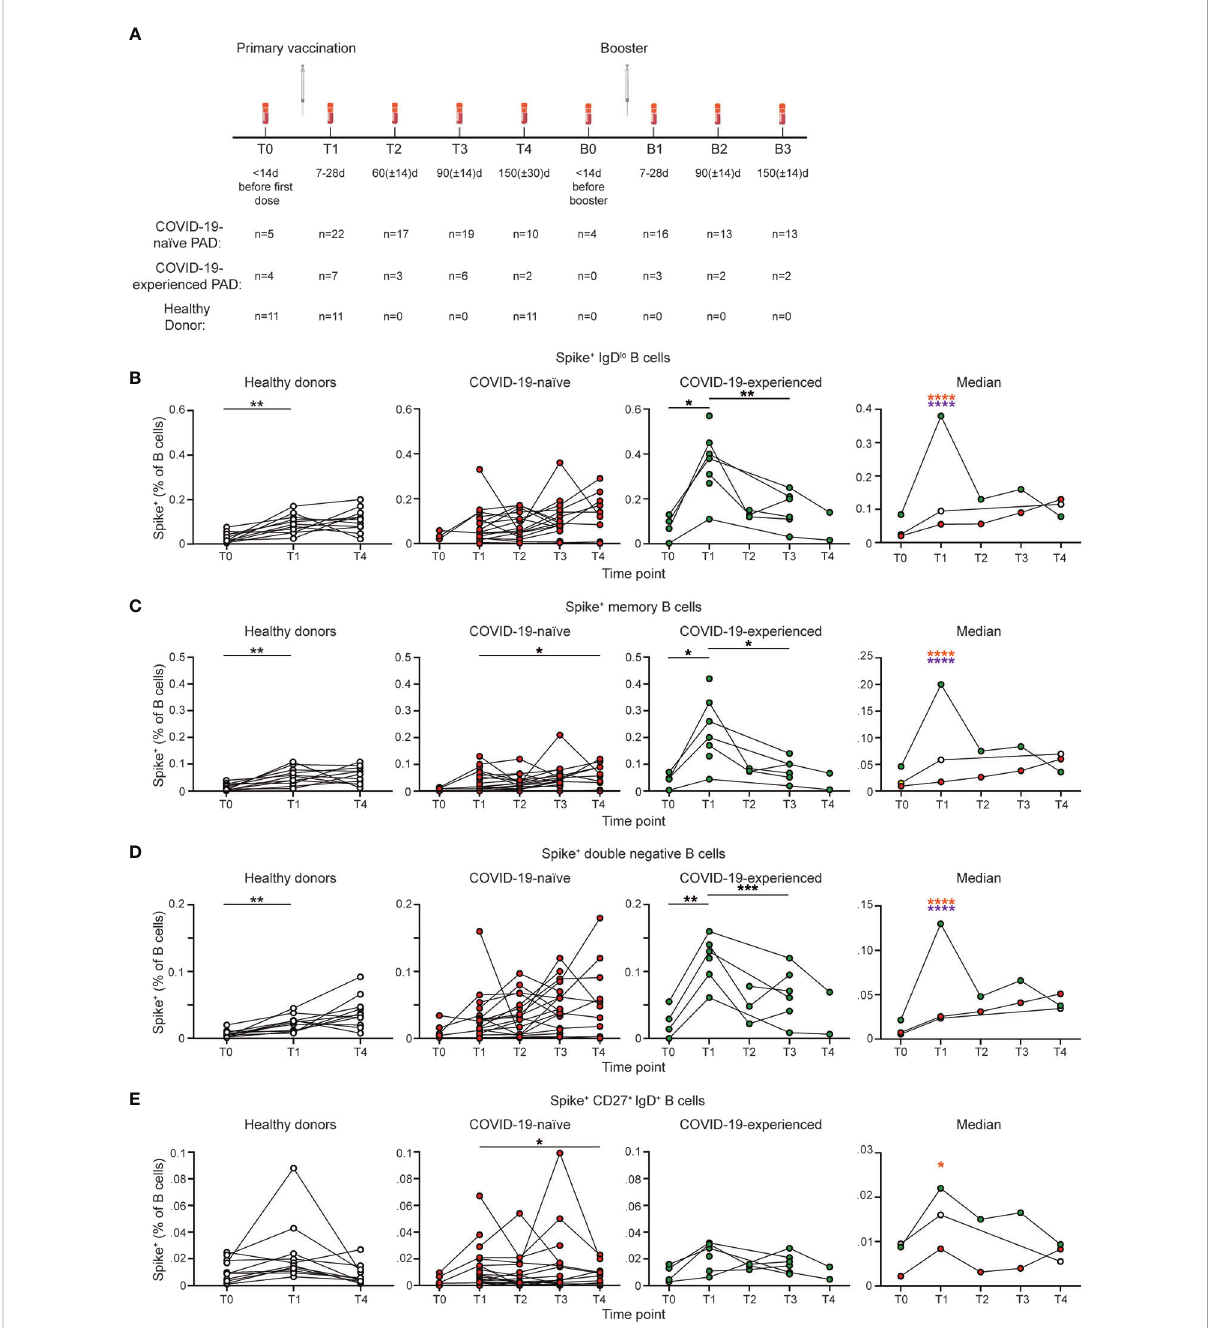
FIGURE 1 COVID-19-experienced PAD patients have elevated spike-speci fi c B cell response following primary vaccination series. (A) Schematic of study design including time points in which PBMCs were obtained and number of samples per time point for each group. (B) Representative fl ow cytometry plots of the gating strategy used to identify IgD lo Spike + B cells. Percentage of (C) IgD lo , (D) memory (IgD lo CD20 + CD38 int-lo CD27 + ), double negative (IgD lo CD20 + CD38 int-lo CD27 - ), and (E) IgD + CD20 + CD38 int-lo CD27 + Spike + cells amongst the B (Live CD19 + CD3 - ) cell population in the healthy donor (left, white), COVID-19-naïve PAD (middle left, red), and COVID-19-experienced PAD (middle right, green) groups. Median percentage of B cells that comprise each population in all groups is shown on right. Statistical analyses in (B – E) were performed using a mixed-effects model (for trends found between time points) or two-way ANOVA (for trends found between groups shown on the median graphs) with Fisher ’ s least signi fi cant difference testing. Signi fi cance testing between time points was limited to comparisons relative to T1. Above the median graphs, an orange asterisk indicates a comparison between the COVID-19-naïve and -experienced groups, and a purple asterisk indicates a comparison between the COVID-19-experienced and healthy donor groups (* p < 0.05; ** p < 0.01; *** p < 0.001; **** p < 0.001). See also Figure